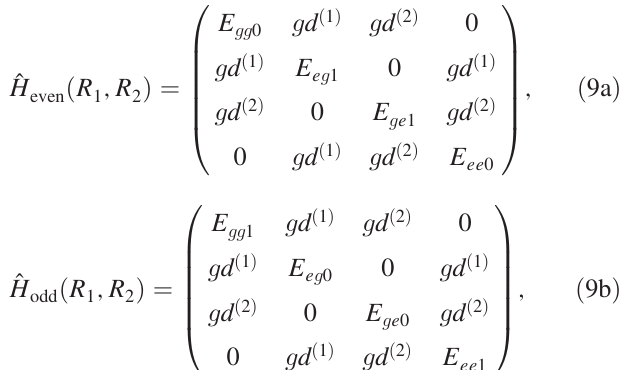
FIG. 5. (a) Uncoupled potential energy surfaces of two anthracenelike molecules in the singly excited subspace: E R 1 ; R 2 Þ (blue), and E R 1 ; R 2 Þ (green). (b) Coupled PES for g ¼ 0 . 002 a : u : and (c) g ¼ 0 . 013 a : u : , corresponding to (orange), E eg 0 ð gg 1 ð the lower polariton (orange), dark state (blue), and upper polariton (green). For clarity, only parts where R 1 < R 2 are shown (note that the system is symmetric under the exchange R 1 ↔ R 2